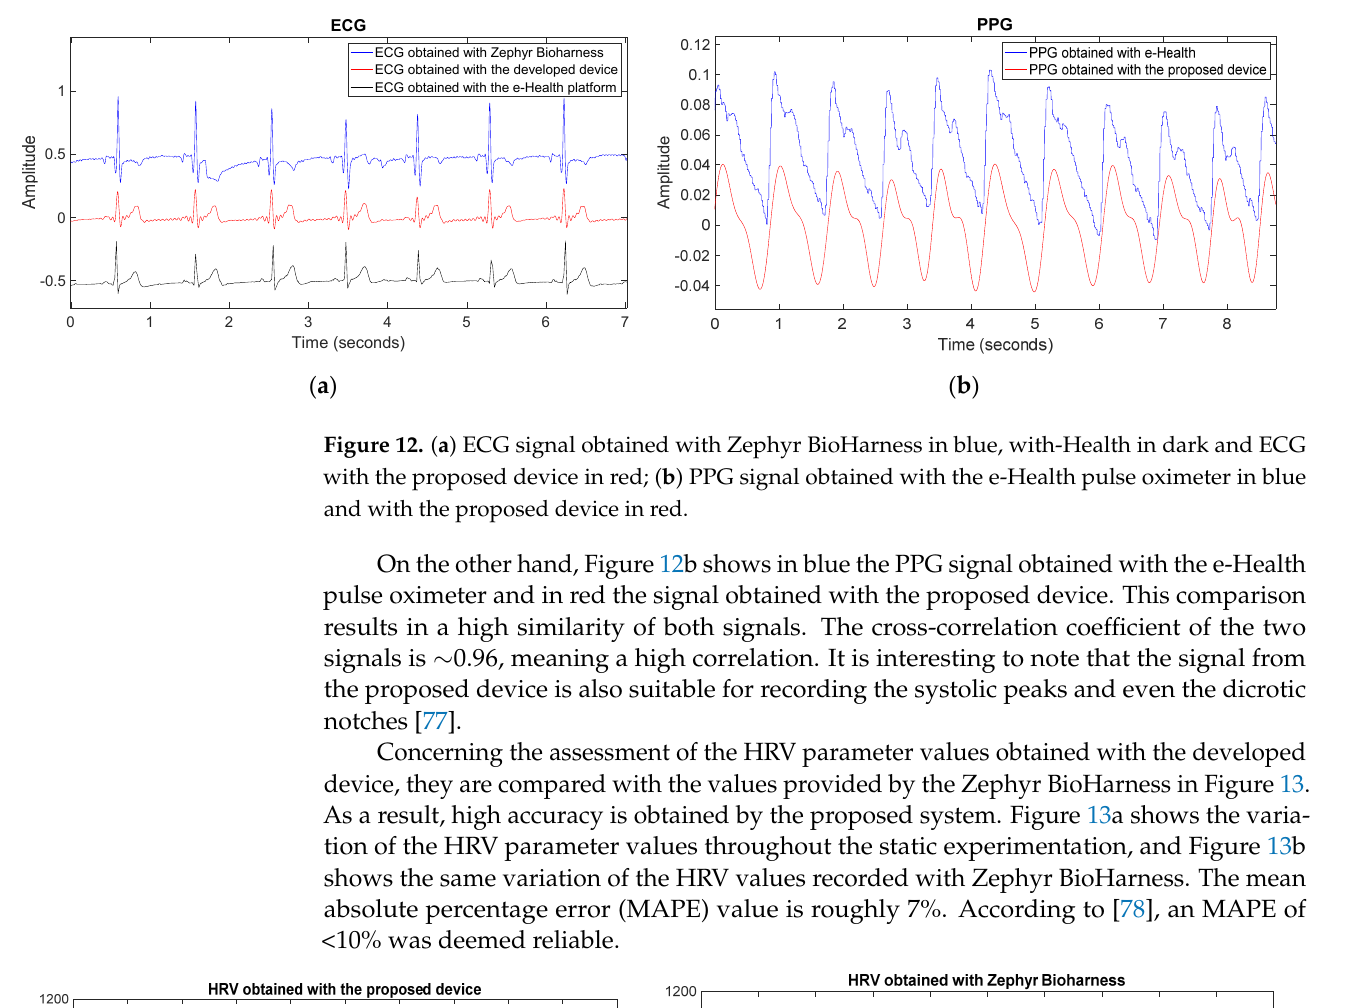
Figure 13. ( a ) Variation of HRV parameter values obtained with the proposed device; ( b ) Variation of HRV parameter values obtained with Zephyr Bioharness.